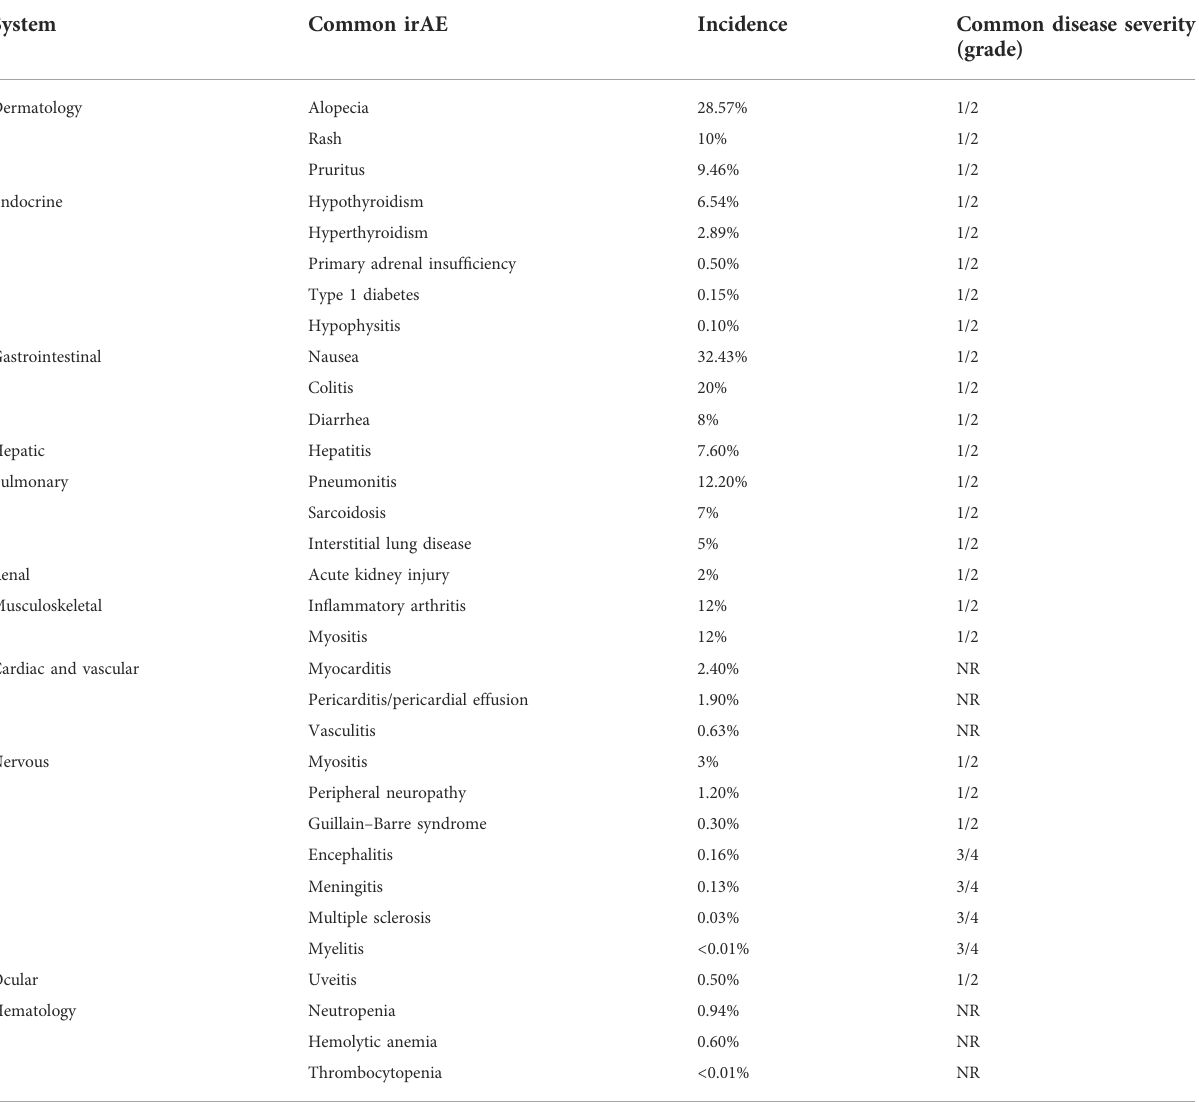
TABLE 2 Incidence and disease severity of common